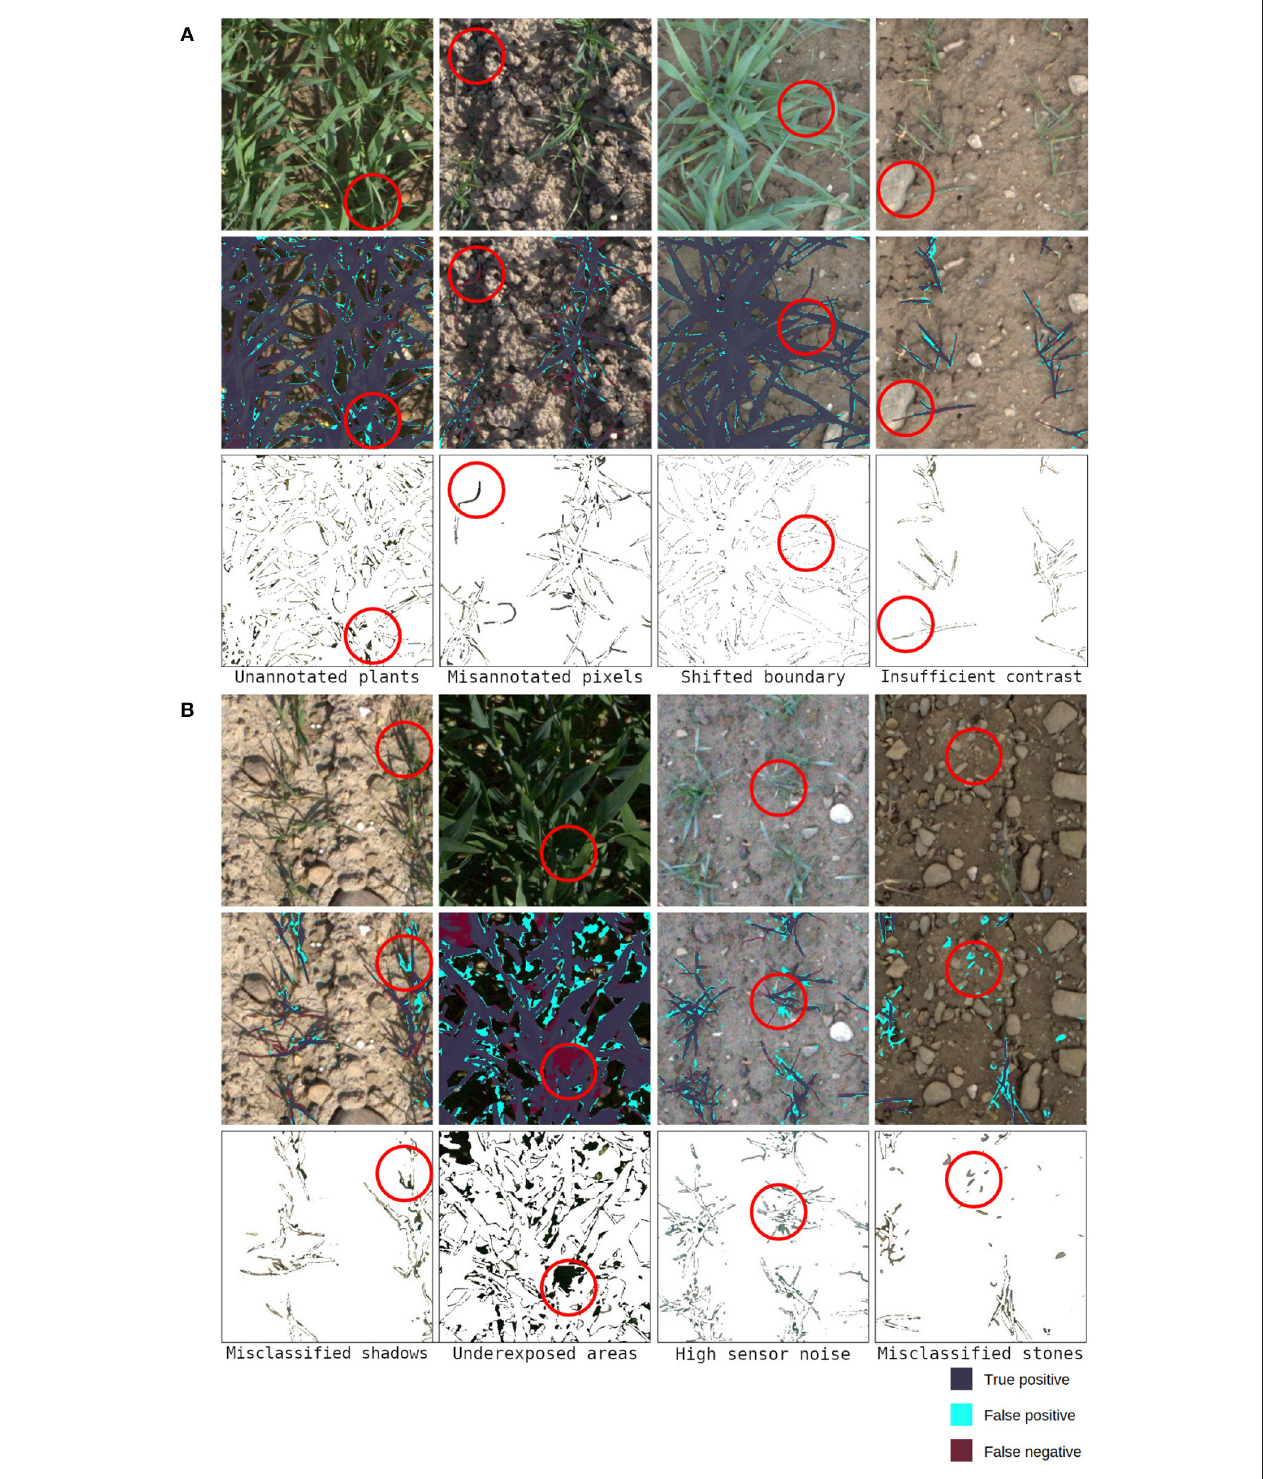
FIGURE 5 | Examples of sources of error: (A) depicts cases linked to inconsistencies in labels, (B) shows failure cases of the algorithm. 1st row-original image, 2nd row-evaluated predictions, 3rd row-underlying values of misclassified parts of the image. Please do zoom in for inspection on the pixel level. The highlighted areas will be referred to in sections 3.2 and